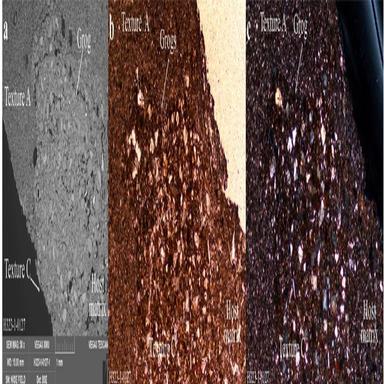
Micrographs of the tempered grog in Type C texture. a): BSE micrograph; b): Petrographic under the plane polarized light); c): Petrographic under the crossed polarized light. Notice the grog has a darker color than its host matrix. (For interpretation of the references to color in this figure legend, the reader is referred to the Web version of this article.)